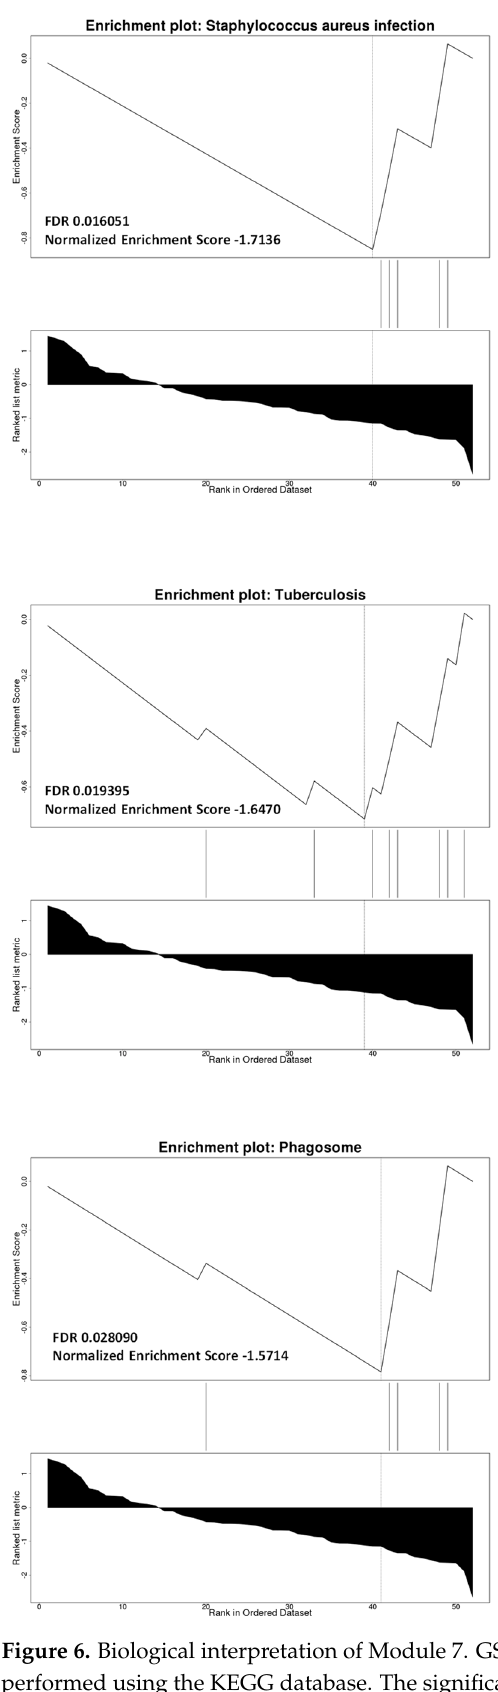
Figure 6. Biological interpretation of Module 7. GSEA analysis for the genes belonging to Module 7 performed using the KEGG database. The significant pathways are shown.